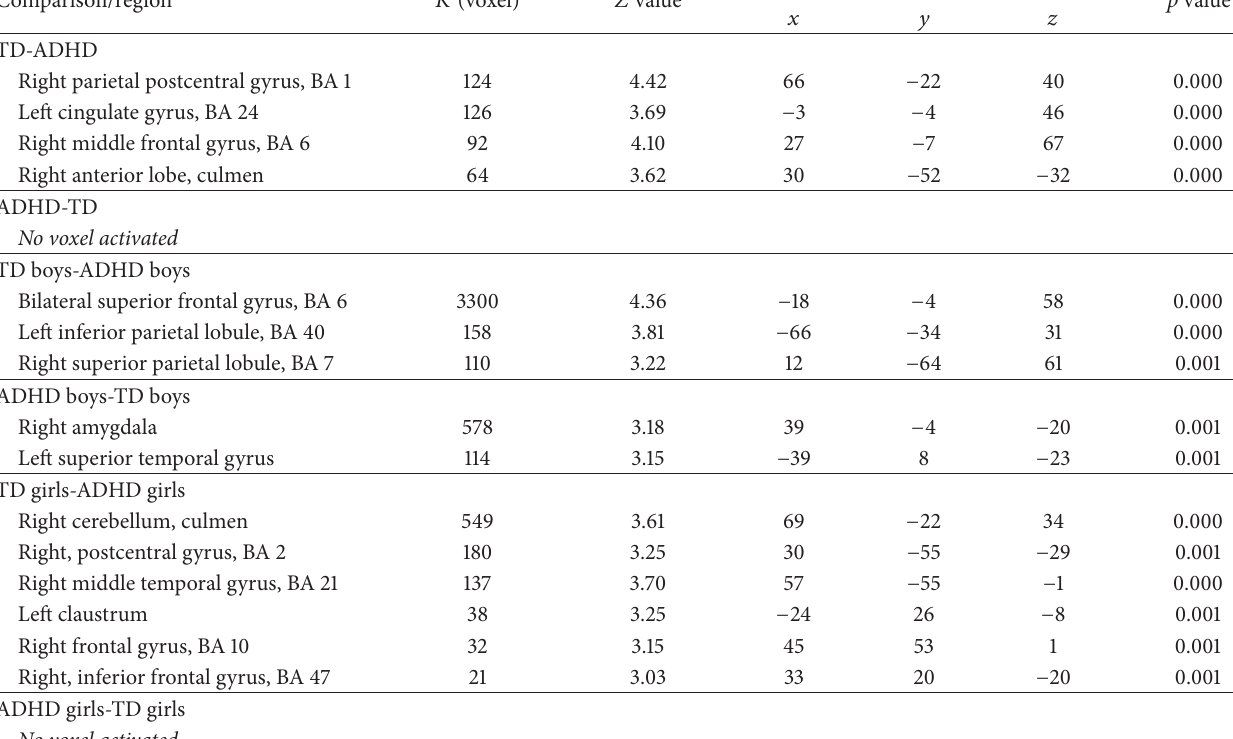
Table 4: Brain activations during forethought: contrast INCO-CO in participants with ADHD and typically developing (TD) youth. Comparison/region 𝐾 (voxel)